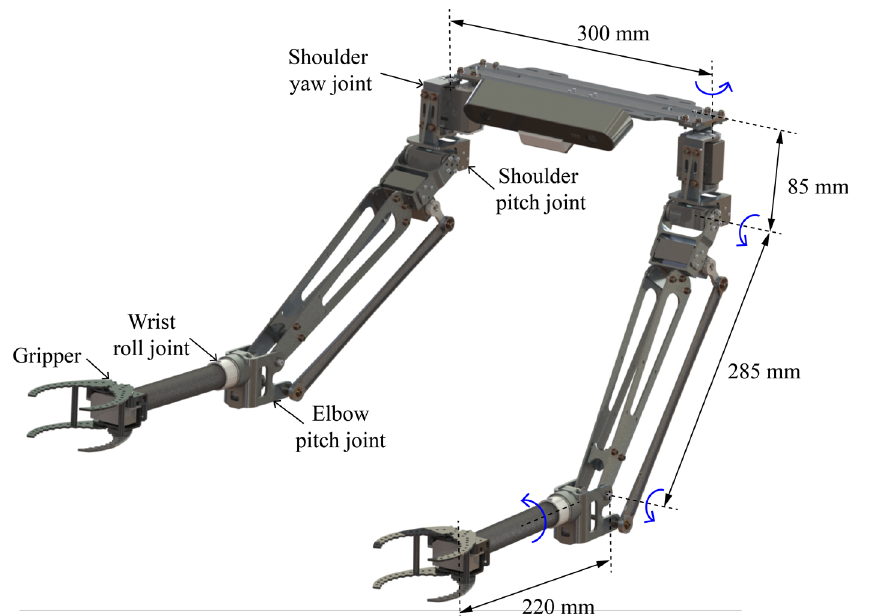
Figure 2. Structure diagram of 8-DOF lightweight and dexterous dual-arm manipulator.